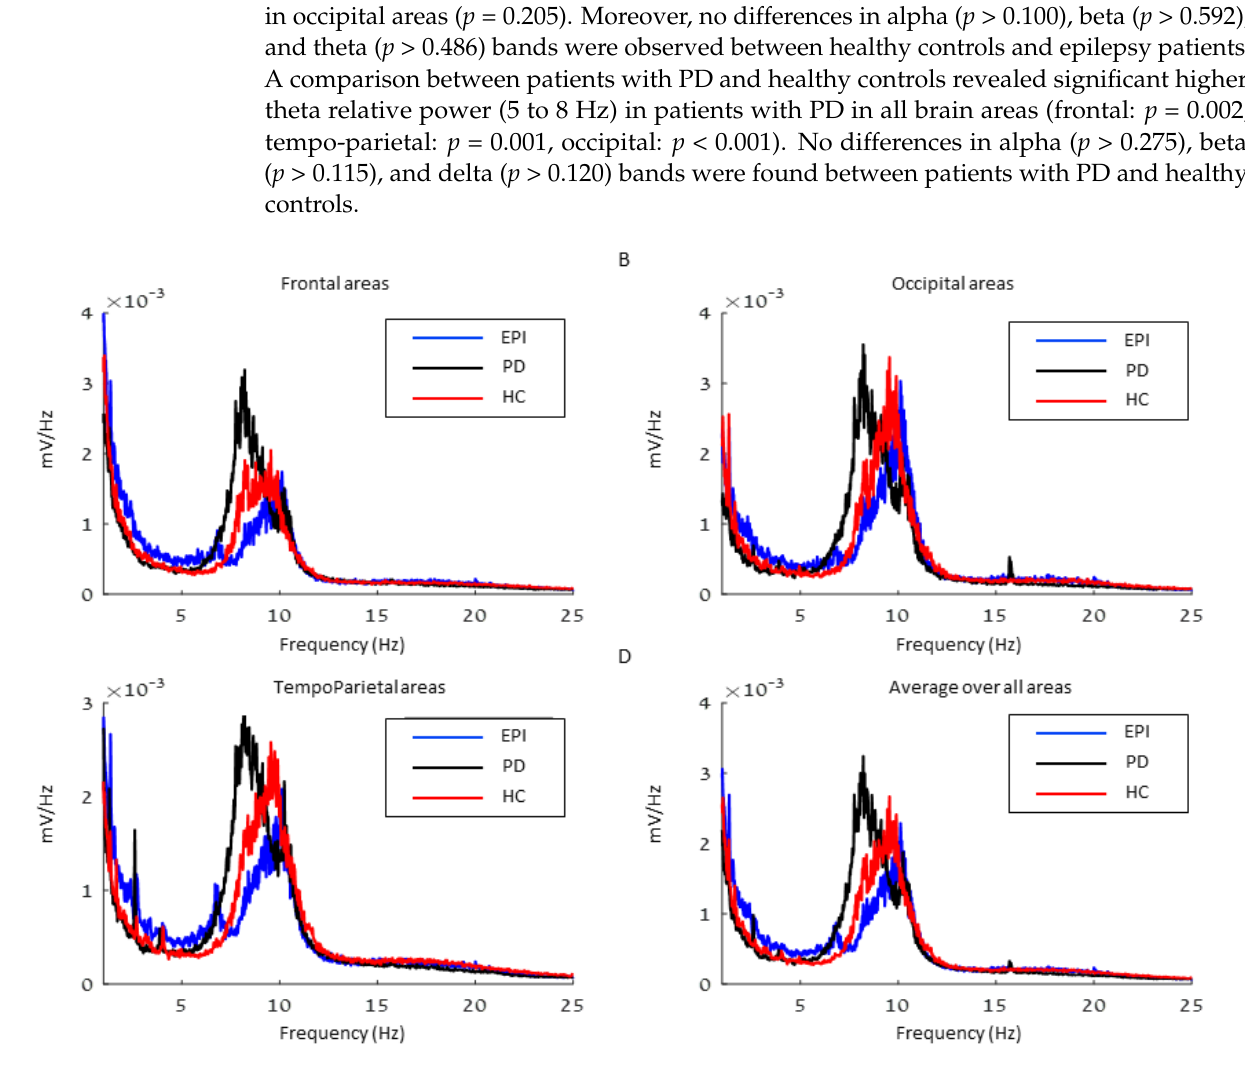
Figure 1. The average spectrum of each group in ( A ) Frontal areas, ( B ) Occipital areas, ( C ) Tempo- Parietal areas, and ( D ) an average over all areas. EPI = Epilepsy, PD = Parkinson’s disease, HC = Healthy control.